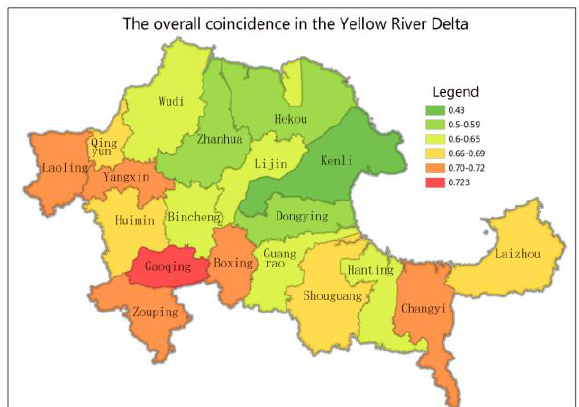
Figure 2. Corresponding relationship between the two types of data